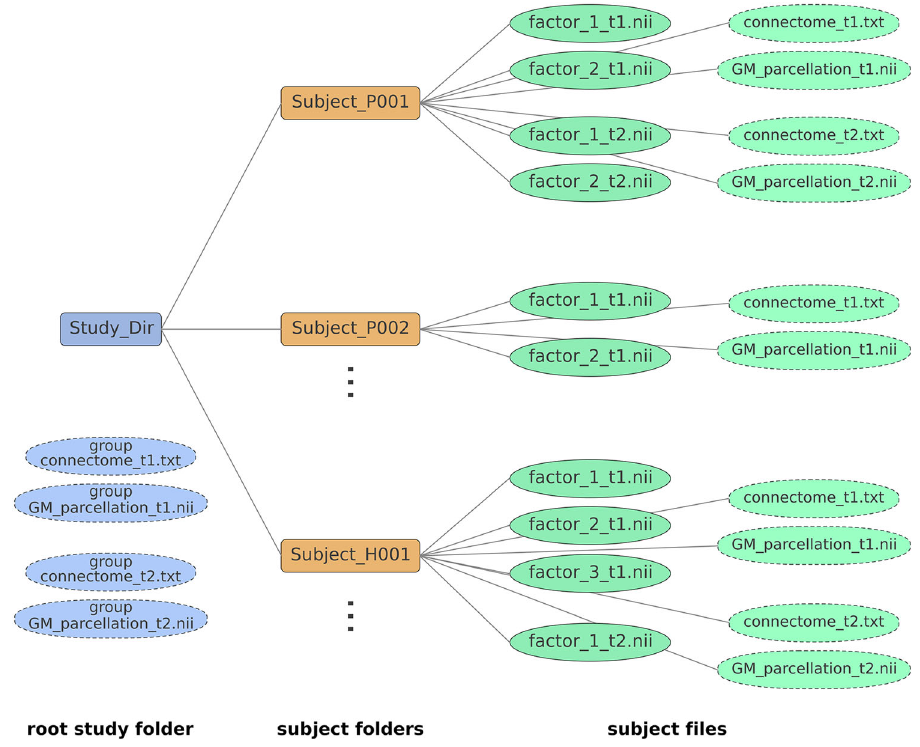
Fig. 7 Schematic for data organization in an MCM study. As mentioned above, if the brain parcellation(s) and/or connectivity information are only available at the group level (e.g. coming from a template or another study), the parcellation(s) and/or connectome fi les can be, alternatively, saved at the root folder containing all the subjects. Please be sure to include at least one connectome matrix for the fi rst modality, with the same number of rows and columns (i.e. regions) that your